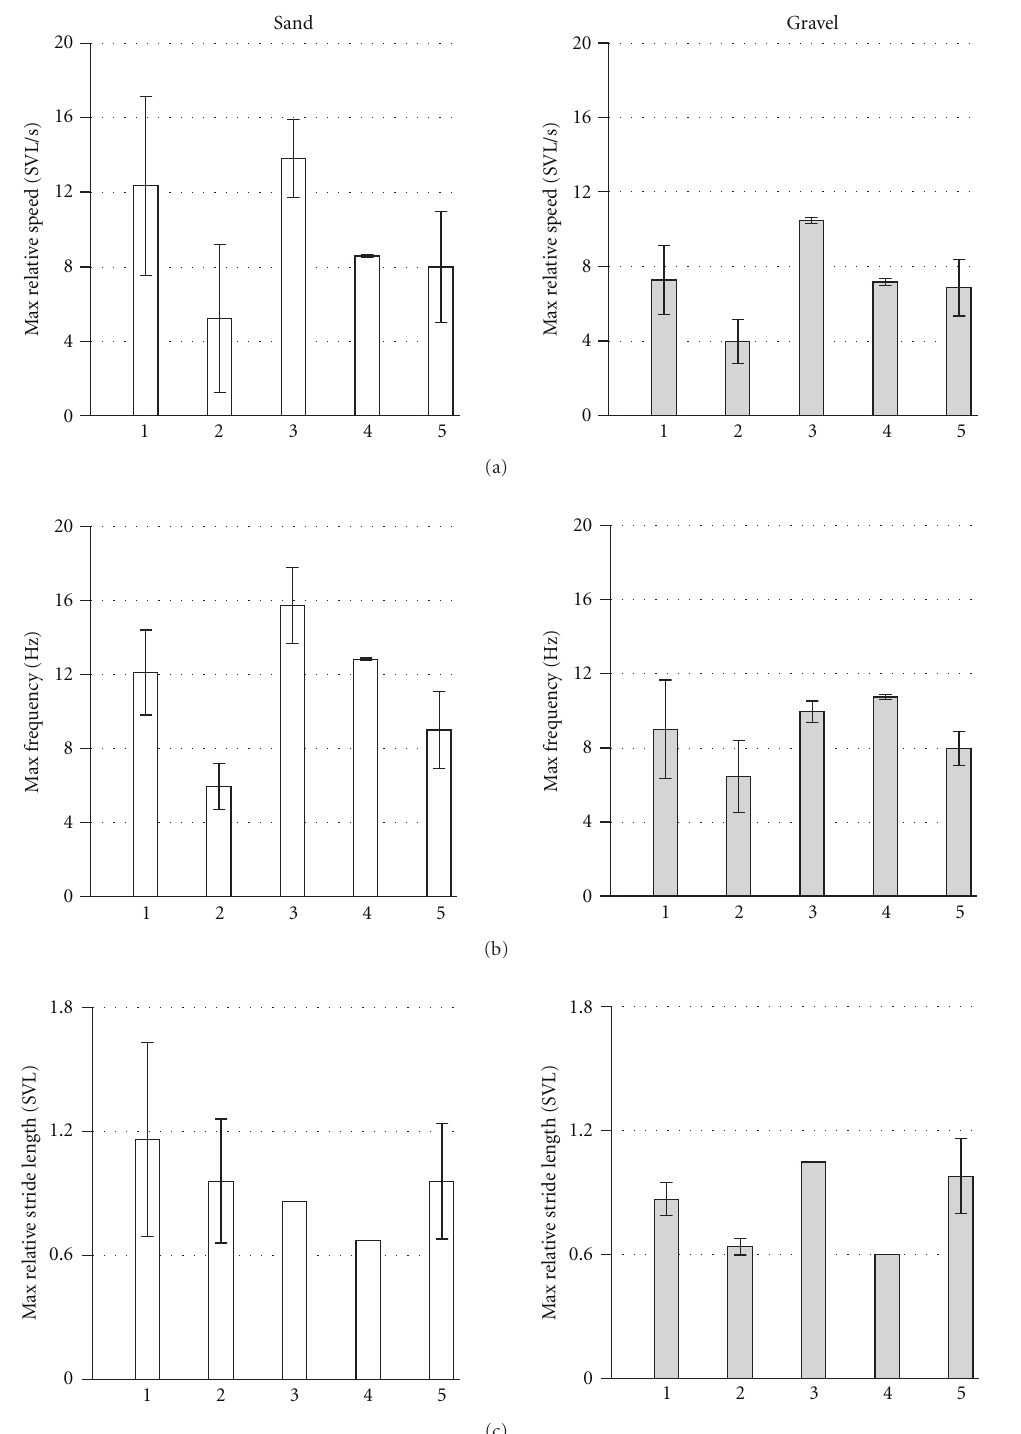
Figure 4: Comparison of the (a) maximal relative speed, (b) maximal stride frequency, and (c) maximal relative stride length of five Gymnophthalmidae species running on sand and gravel. 1 = Vanzosaura rubricauda ( n = 16), 2 = Procellosaurinus tetradactylus ( n = 16), 3 = Micrablepharus maximiliani ( n = 4), 4 = Colobosaura modesta ( n = 4), and 5 = Colobodactylus taunayi ( n = 16). These are average maximal values reach by studied individuals in each species. Bars are SD. Data other than for species 5 are from Renous and coauthors [15] (1-2) and Renous and coauthors [14]